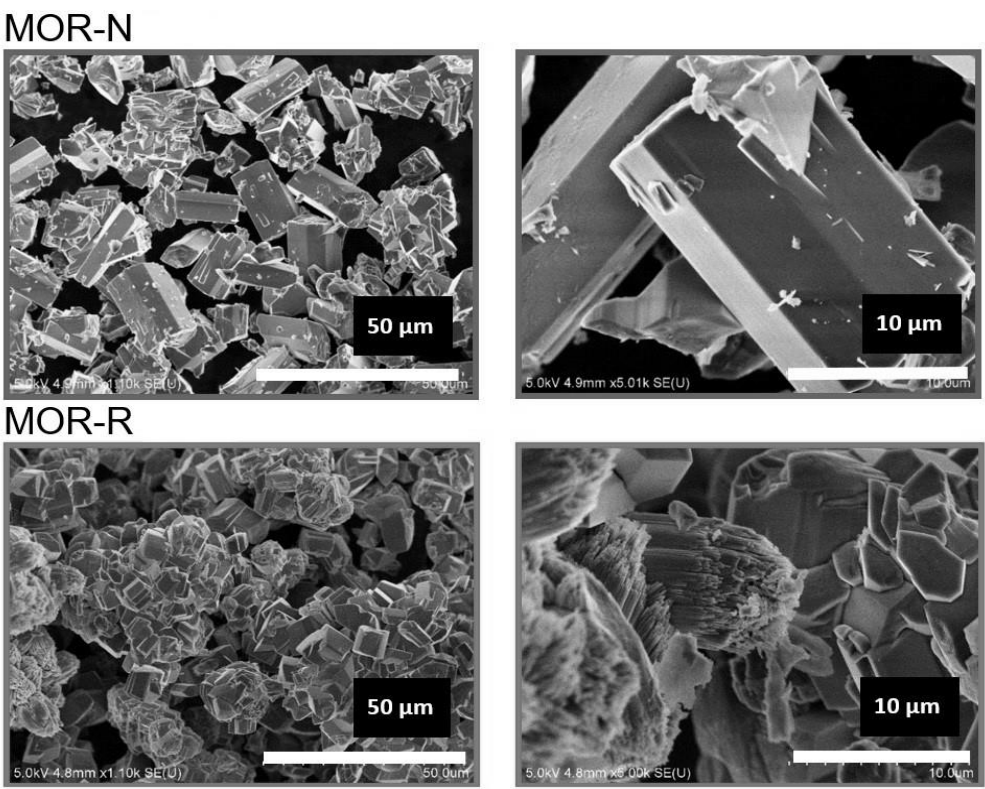
Figure 10. Comparison of the zeolites prepared by traditional synthesis with their solvent-free counterparts showing differences in crystal size and morphology (Reprinted with permission from [43]. Copyright: 2019, John Wiley and sons.).